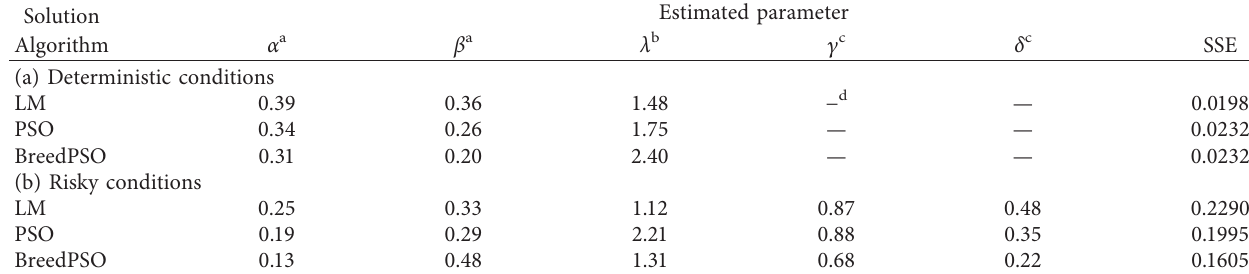
Table 3: Calibration results of MA-TC model parameters under deterministic and risky conditions. Solution Estimated